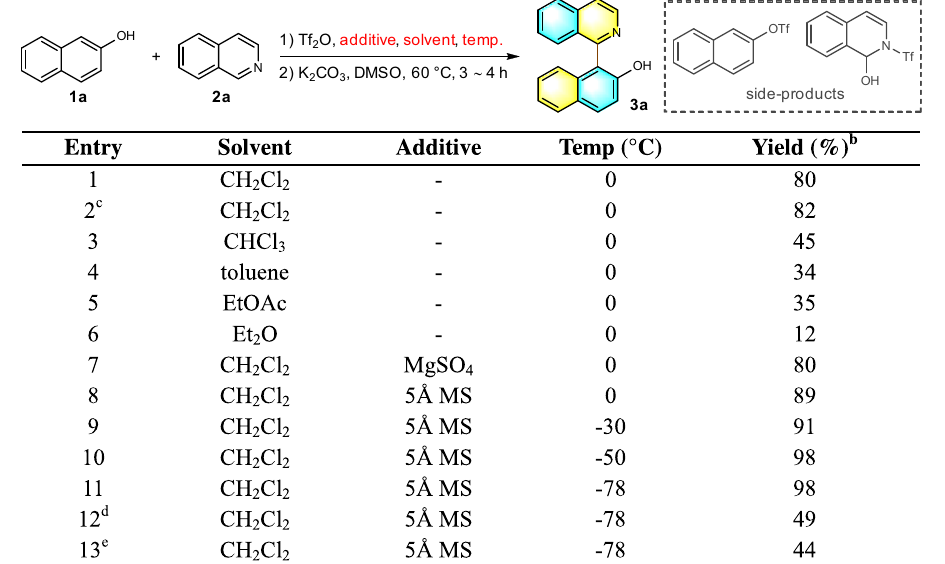
Fig. 3 Optimization of the conditions a . a Reaction conditions: To a Schlenk tube was added additive (0 or 250 mg), 2a (1.25 mmol), CH 2 Cl 2 (4 mL) and Tf 2 O (0.5 mmol) successively. After stirring at speci fi ed temperature for 0.5 h, a solution of 1a (0.5 mmol) in CH 2 Cl 2 (4 mL) was added. The reaction mixture slowly increased to room temperature, and then continued to stir for 2 h. b Isolated yield. c 1a (0.55 mmol) was used. d 2a (0.5 mmol) and Et 3 N (1.5 eq.) were used. e 2a (0.5 mmol) and NaHCO 3 (1.5 eq.) were